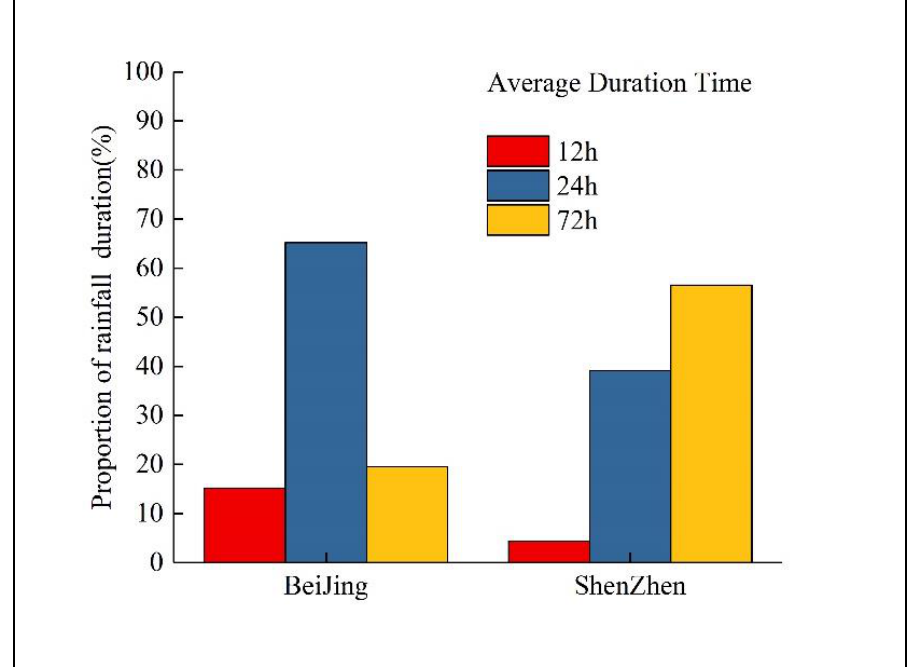
Figure 3. Comparison chart of rainfall with different duration.